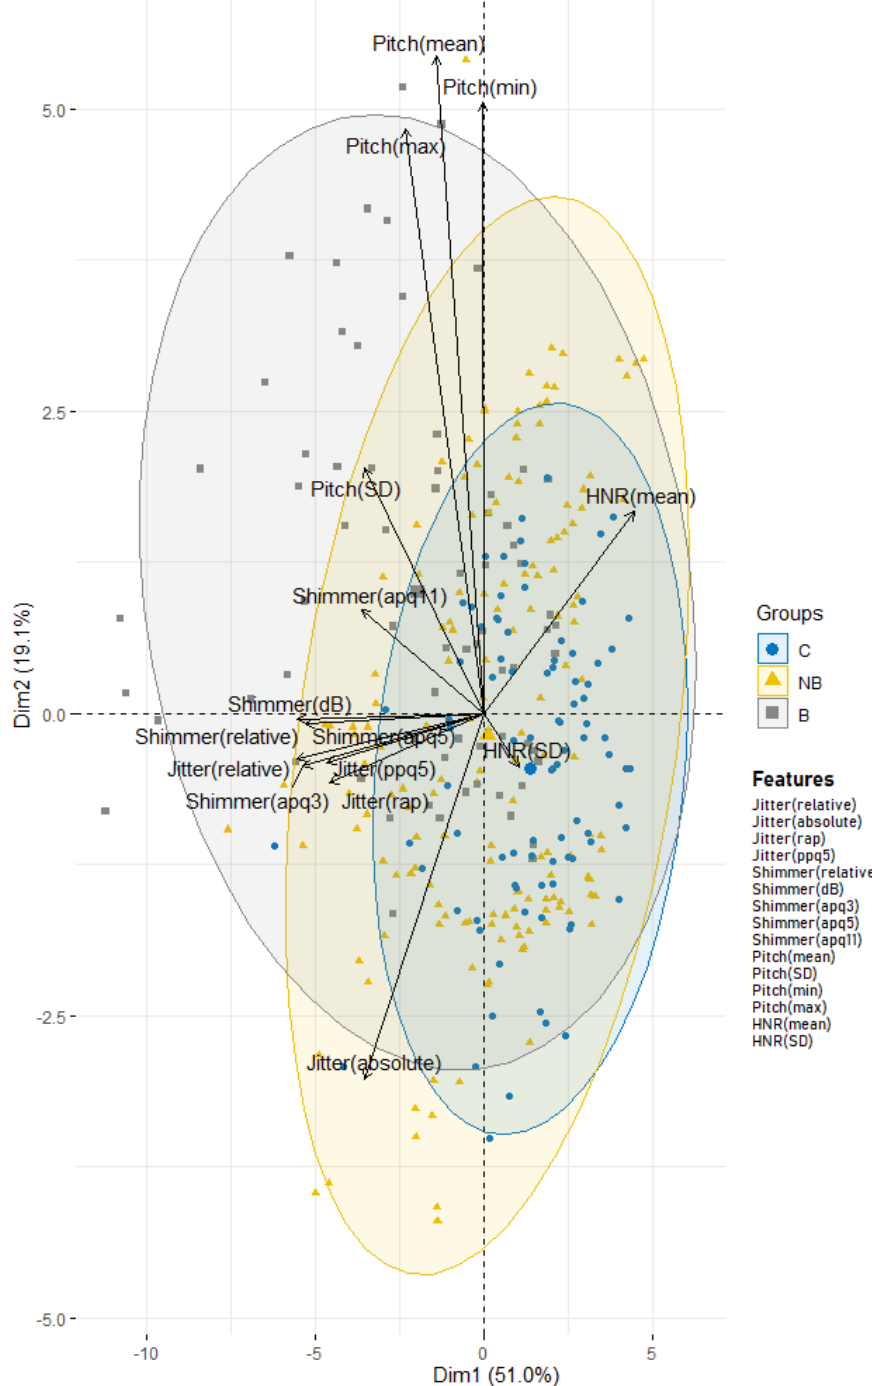
Figure 2. Principal component analysis biplot chart representing the variance of the first (Dim1) and second (Dim2) principal components in the control group (C), patients with amyotrophic lateral sclerosis (ALS) without bulbar involvement (NB), and patients with ALS with bulbar involvement (B). HNR: harmonics-to-noise